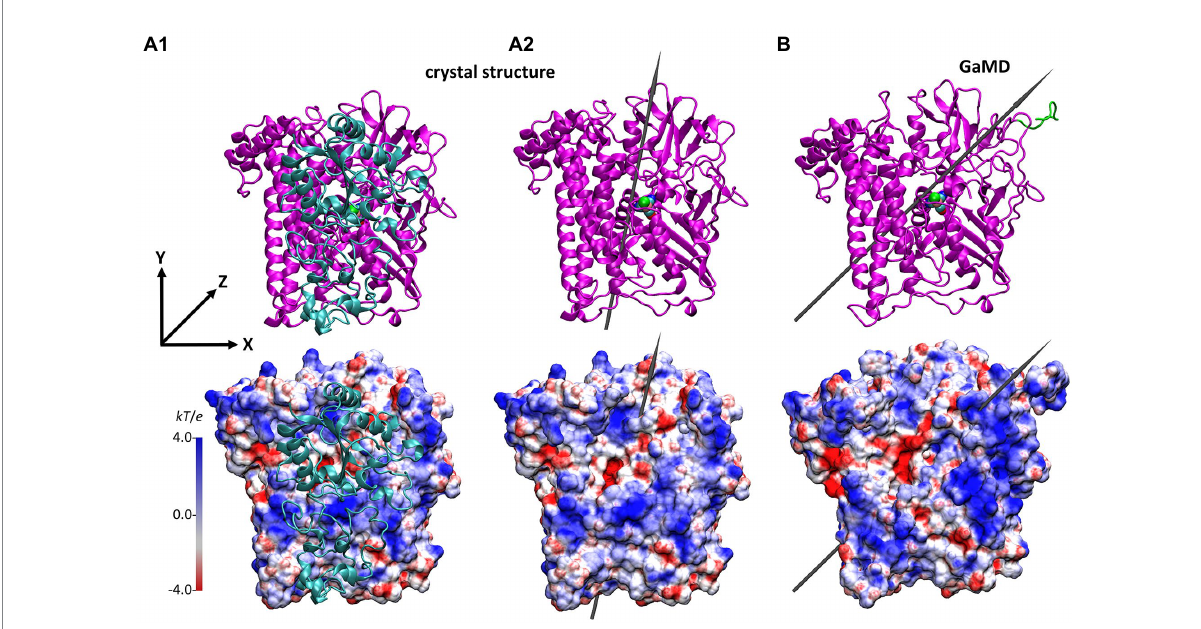
FIGURE 5 Structure and the electrostatic potential surface of the HoxG structures, showing the former dimer interface (other orientations are shown in Supplementary Figure S13). (A) : HoxG subunit from the MBH crystal structure 3RGW (Fritsch et al., 2011), with HoxG MBH (A1) and without HoxG c (A2) the small subunit HoxK. (B) : HoxG m structure taken from simulation 2 after 100 ns. The upper panels show the secondary structure elements. The representation and color codes are taken from Figure 1. The electrostatic potential surface calculated with the APBS (Baker et al., 2001; grid resolution 0.3 Å) is qualitatively displayed (range: − 4 kT/e to 4 kT/e), where red and blue indicate negatively and positively charged regions, respectively. The grey arrows indicate the direction of the dipole moment in monomers HoxG c and HoxG m , ca. 644 Debye (A2) and ca. 740 Debye (B) , respectively. Charges and radii were used as defined in the CHARMM Force-Field (MacKerell, 1998; Best et al., 2012). Comparison to the Cn MBH heterodimer is shown in the SI (Supplementary Figure